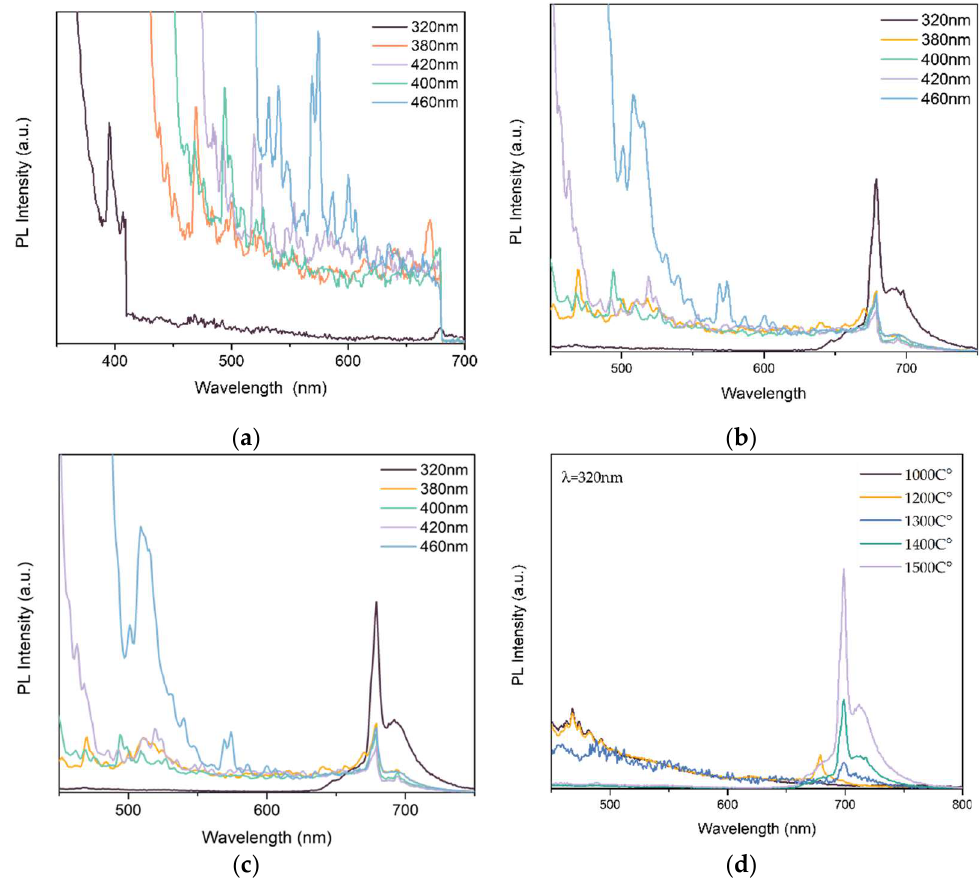
Figure 9. PL spectra of ( a ) ZnAl 2 O 4 : Mn annealed at 1300 ◦ C; ( b ) ZnAl 2 O 4 : Mn annealed at 1400 ◦ C;